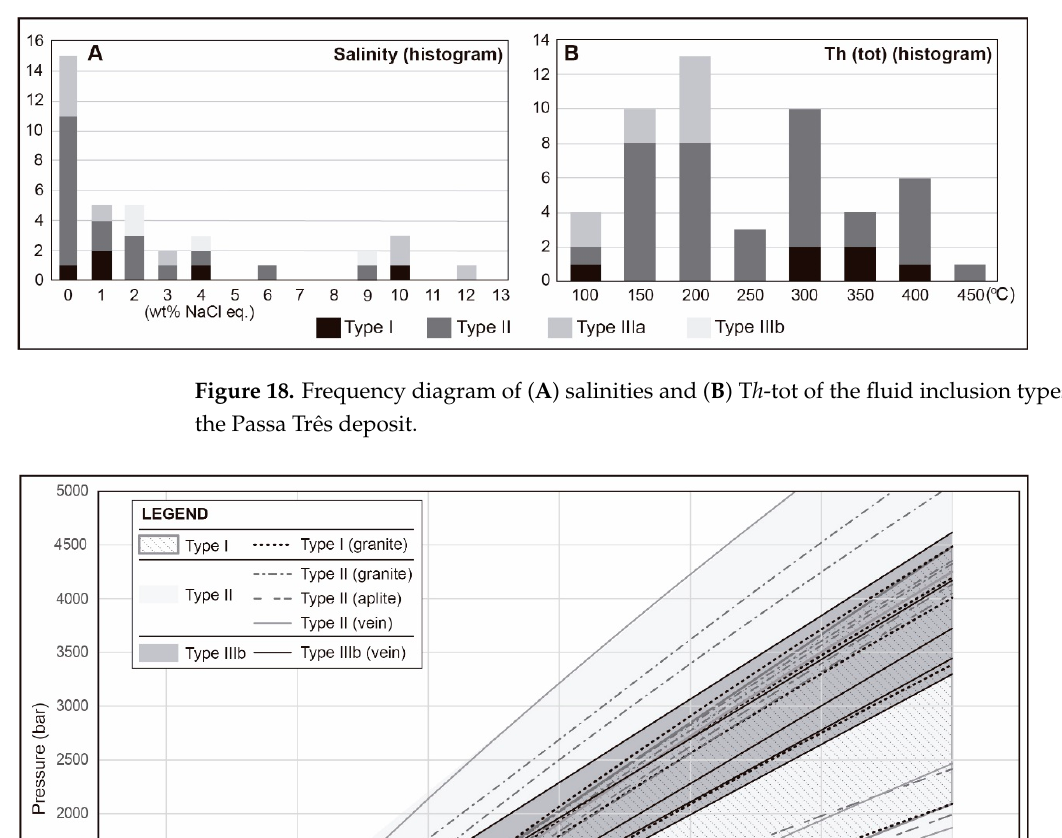
Figure 17. ( A ) Temperature of first melting (T fm ) vs. salinity diagram for the fluid inclusions of the Passa Três gold deposit; ( B ) Total homogenisation temperature (T h -tot) vs. salinity plot of the studied fluid inclusions.